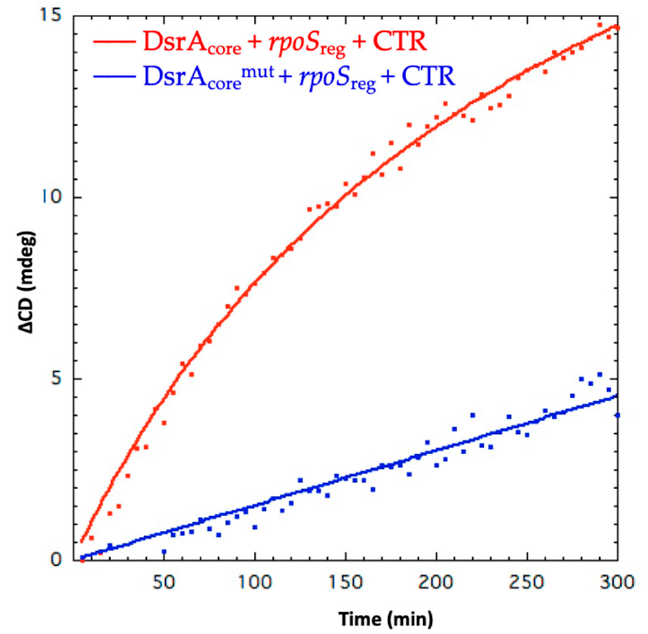
Figure 3. Kinetics of DsrA core and rpoS reg annealing observed at 180 nm. Red: DsrA core + rpoS reg + CTR; blue: DsrA coremut + rpoS reg + CTR. ∆ CD refers to CD at a specific time subtracted from CD at t = 0. Kinetics constant have been measured during initial rate conditions.